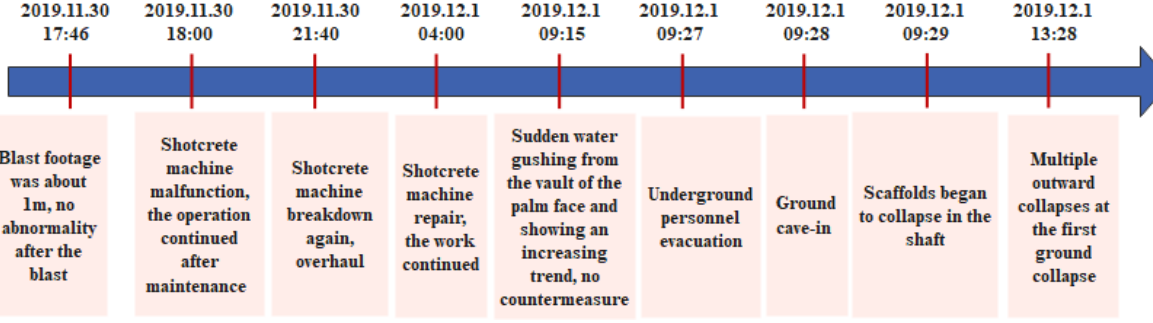
Figure 2. Accident time series diagram.